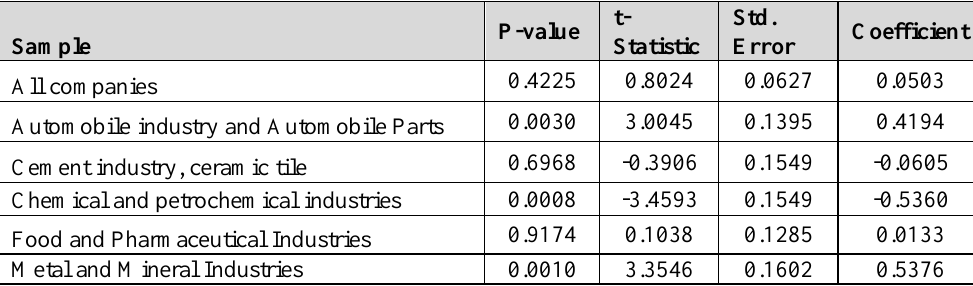
Table 5. Results of the introduction stage and capital investment choice in the type of industries